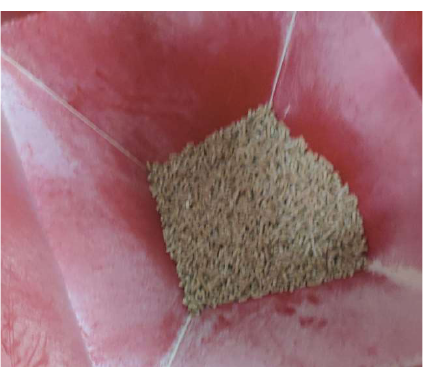
Figure 5. Wood pellets B.